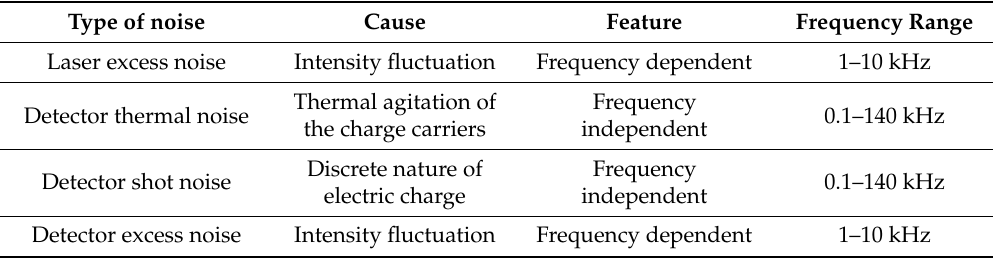
Table 2. Comparison of laser and detector